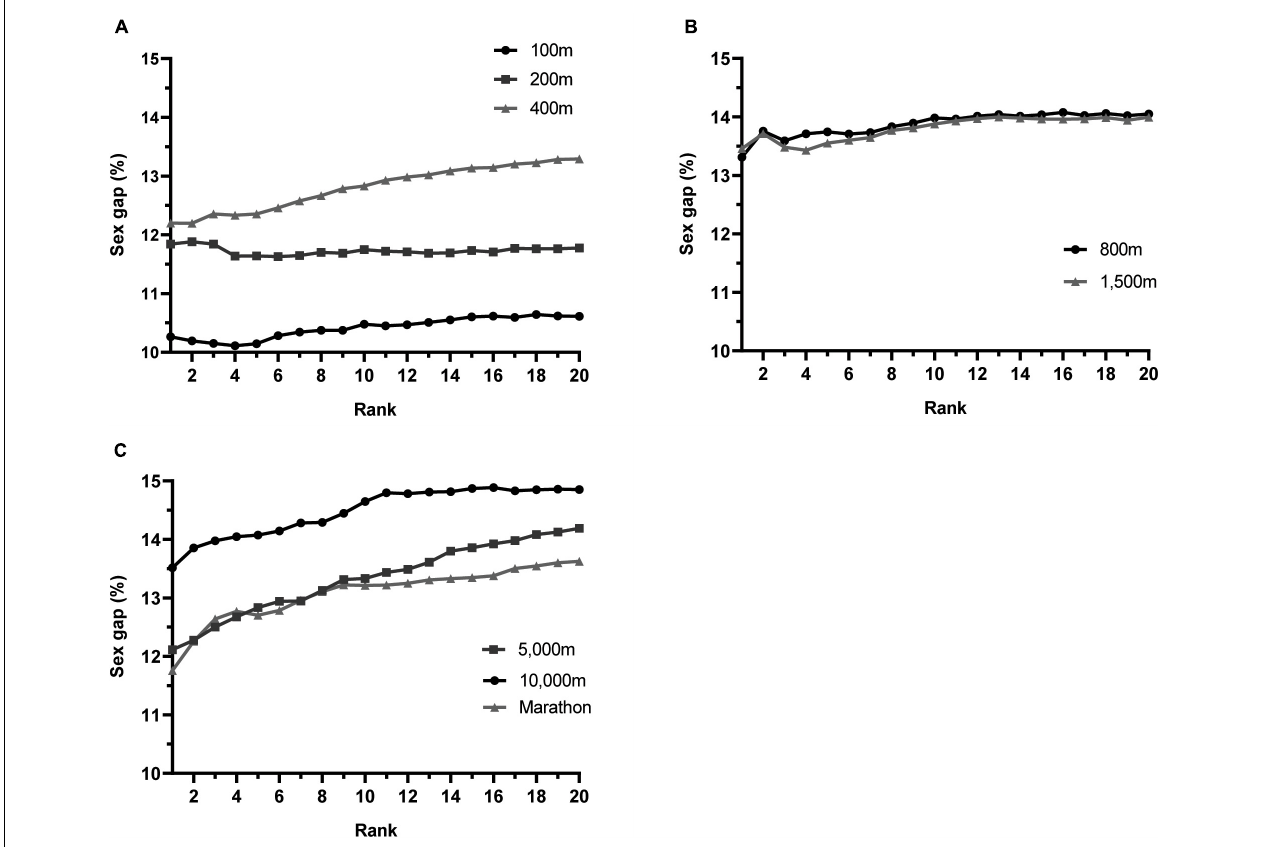
FIGURE 2 | The Sex Gap and Performance Level in Running Events 100 m to Marathon. The sex gap % is calculated as the percent difference between male and female running times, averaged over a 20-year period (2001 – 2020) for each worldwide rank position (1 through 20) for (A) sprint events, (B) middle-distances, (C)